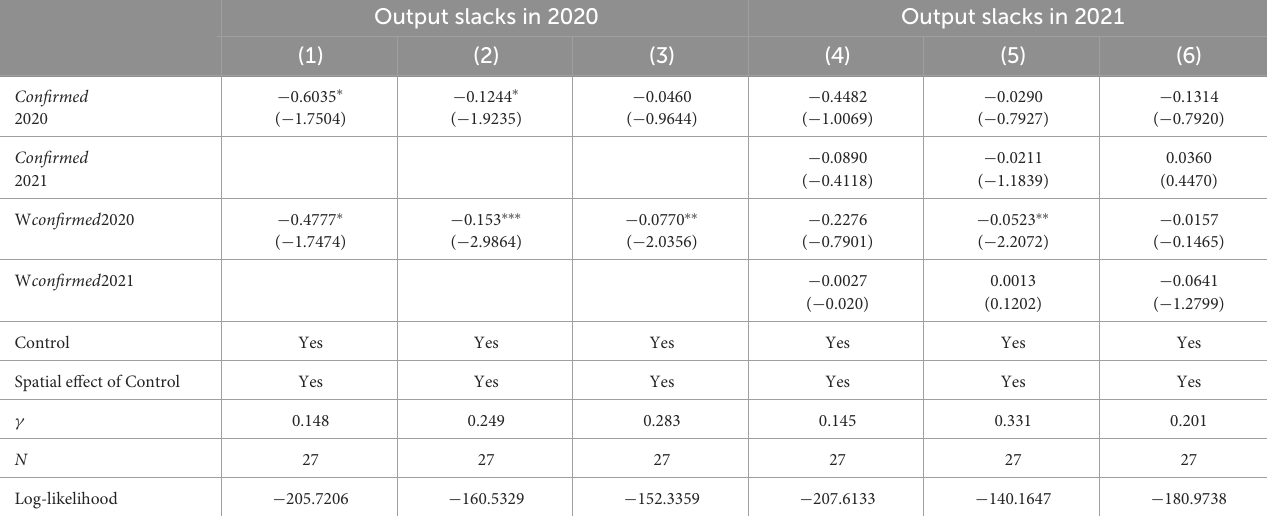
TABLE 8 Spatial SFA model